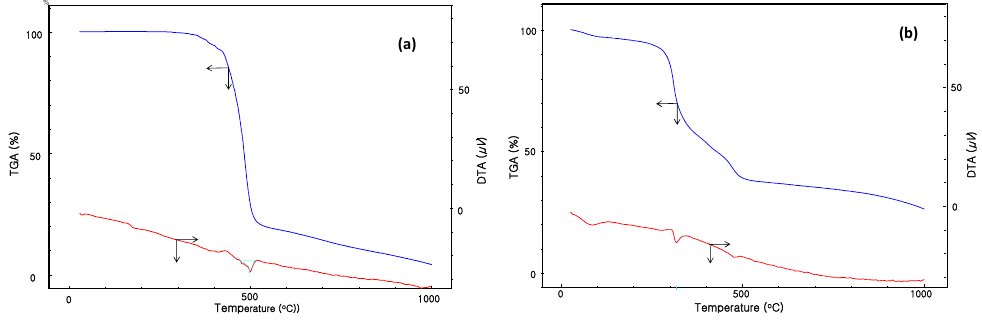
Figure 4. Thermogravimetric analysis (TGA)/differential thermal analysis (DTA) results of ( a ) pure polycarbonate and ( b ) NNT-F.